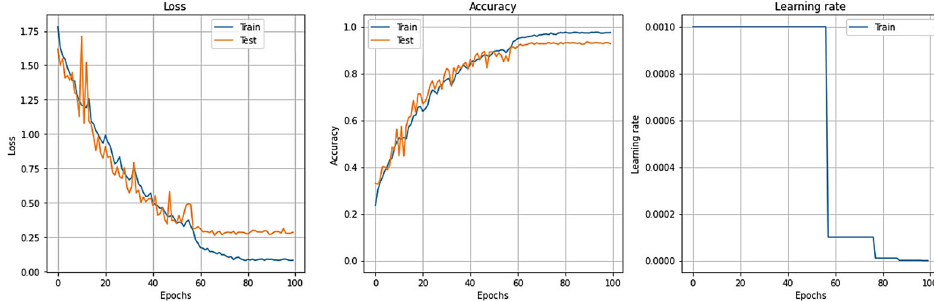
Figure 13. CNN classi fi cation model result.